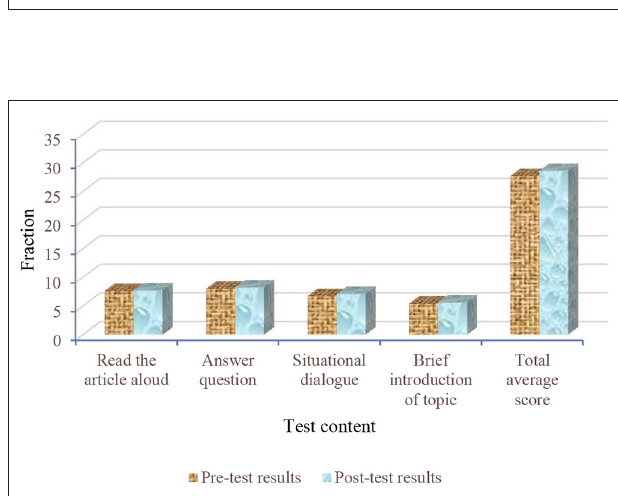
FIGURE 9 | Comparison of pre-test and post-test scores of students in class B.